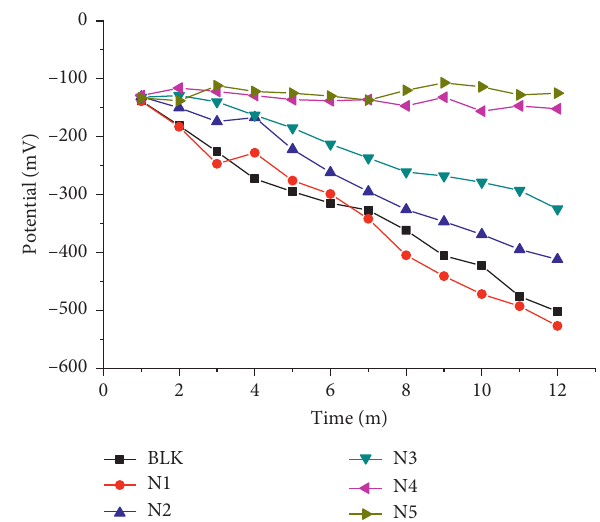
Figure 1: Corrosion inhibitor of NaNO